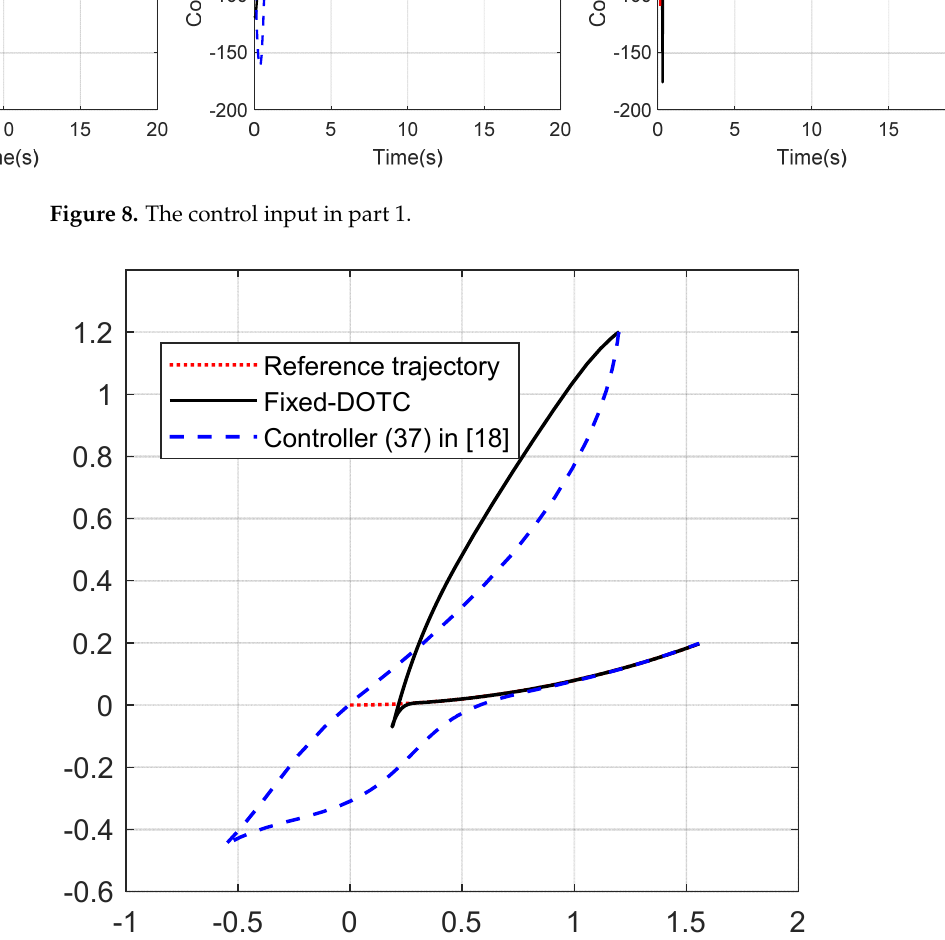
Figure 9. The actual position trajectory and the desired position trajectory in part 2.